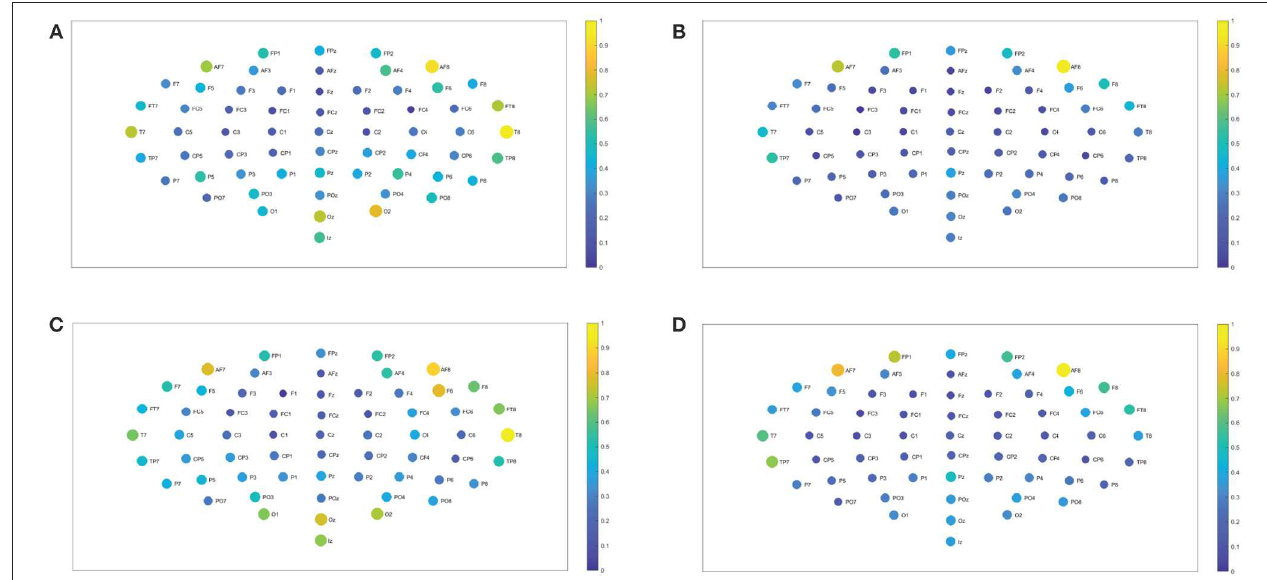
FIGURE 10 | Closeness centrality. (A,B) Show the nodes’ closeness centrality considering 109 subjects when performing the visuomotor task for the 62-channels EEG considering the different oscillation bands beta 1 and beta 2. (C,D) Are the same as (A,B) but considering the imagined task. We consider D = 6 and τ = 1.